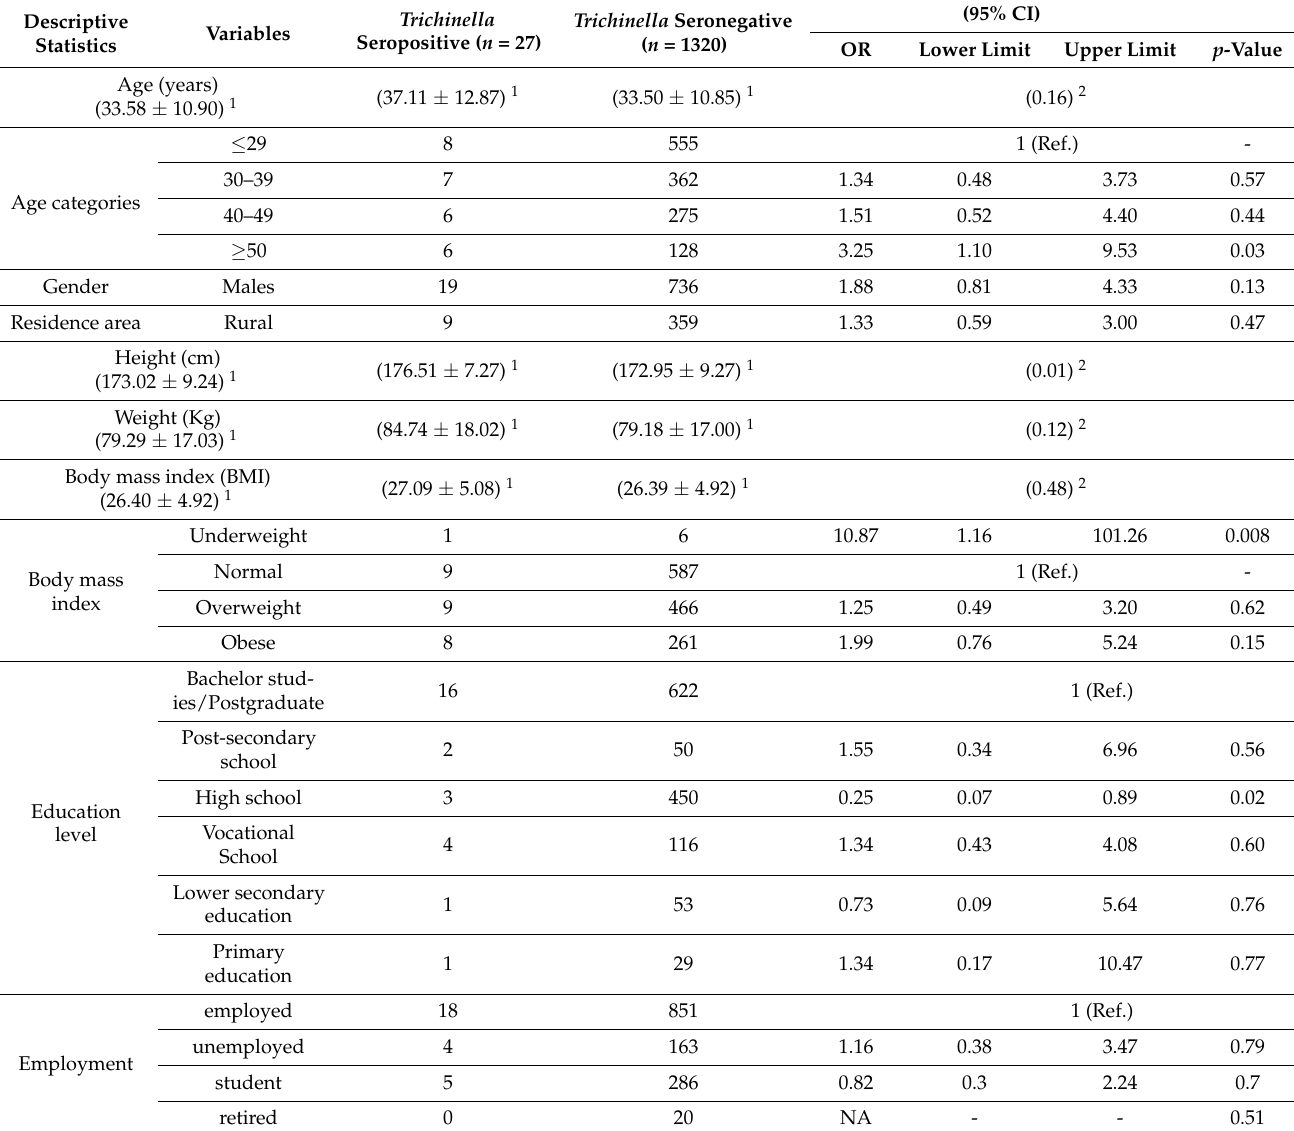
Table 1. Baseline characteristics and descriptive statistics in blood donors ascertained by